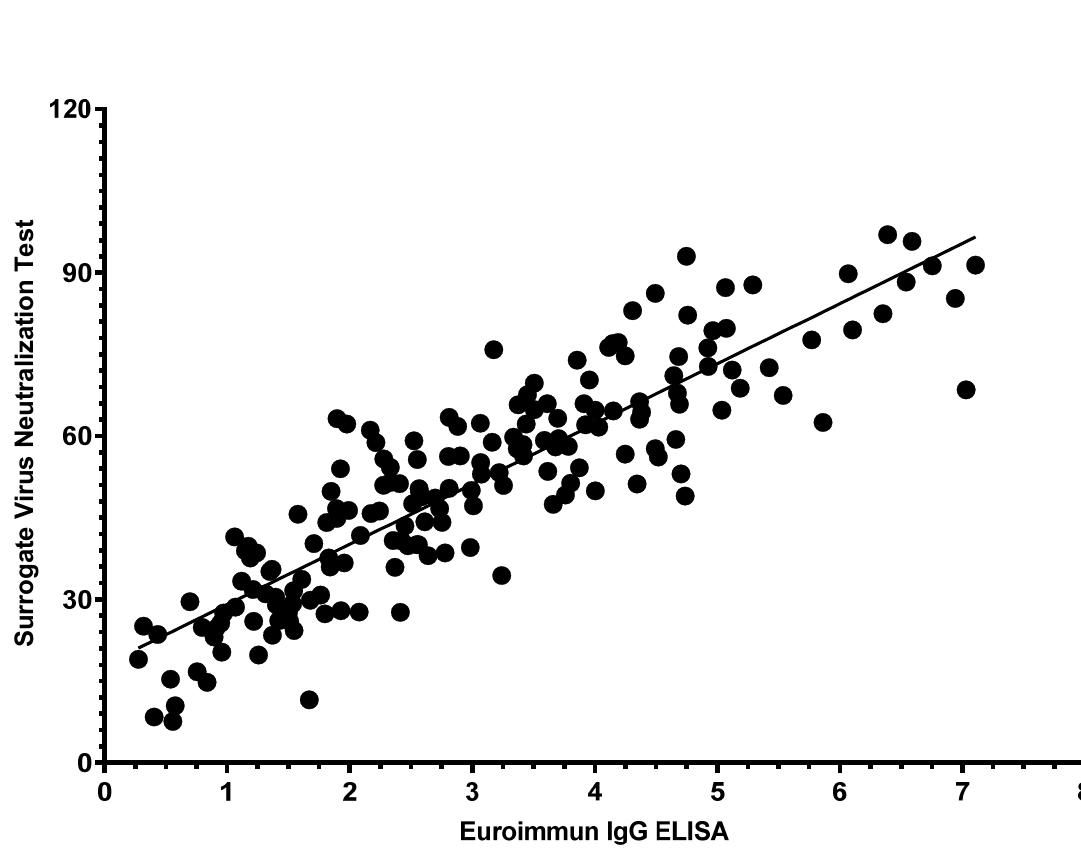
Figure 2. Correlation of values between Euroimmun IgG ELISA and surrogate virus neutralization test. Abbreviations: ELISA, enzyme-linked immunosorbent assay